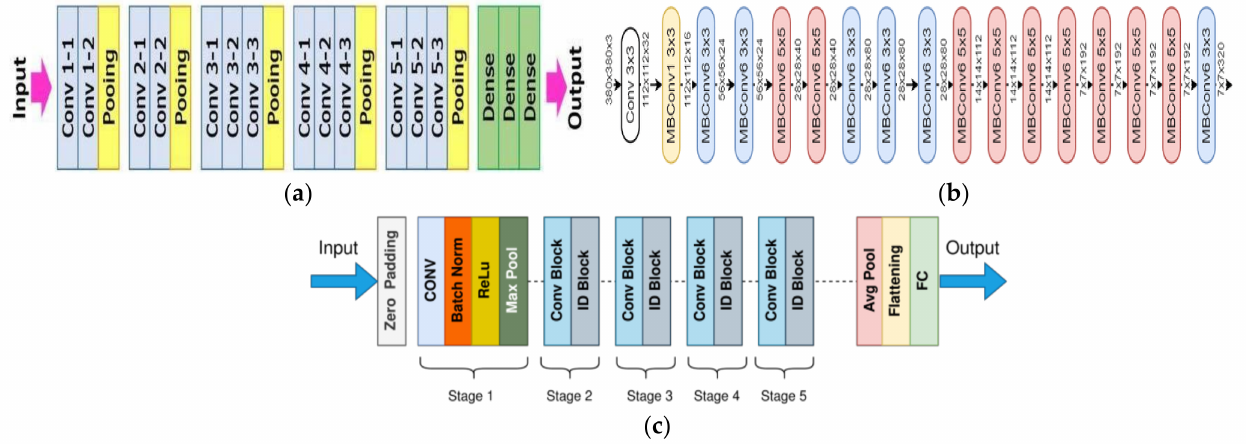
Figure 2. VGG16, EfficientNet B0, and ResNet 50 pre-trained networks architecture. ( a ) VGG16 network architecture [46], ( b ) EfficientNet B0 network architecture [47], ( c ) ResNet50 network archi- tecture